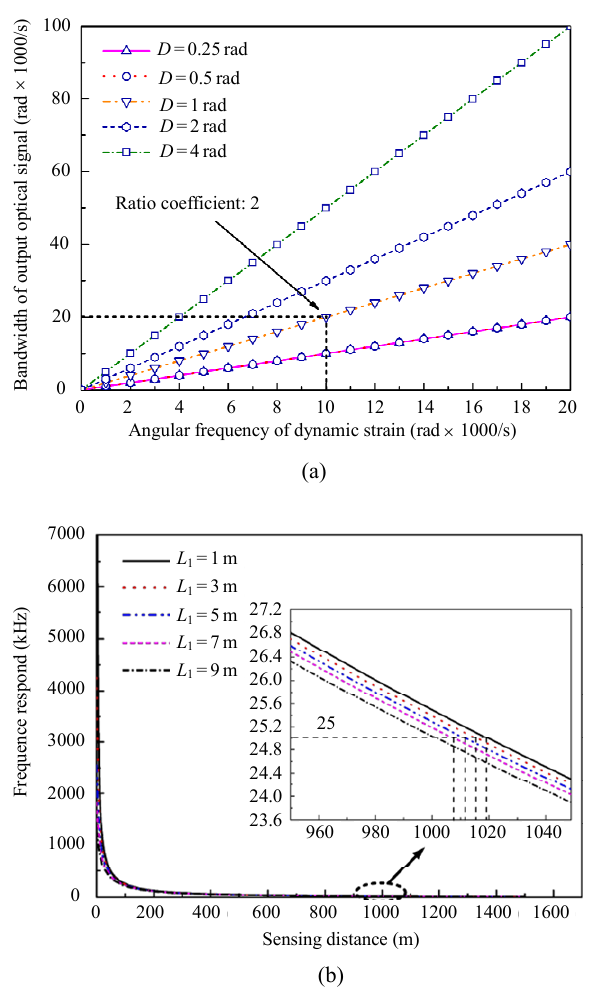
Fig. 4 Analysis of frequency response: (a) the relationship among the bandwidth of optical signal, the phase shift amplitude of optical signal, and the frequency of the external vibration and (b) the relationship among the frequency response, sensing distance, and the spatial